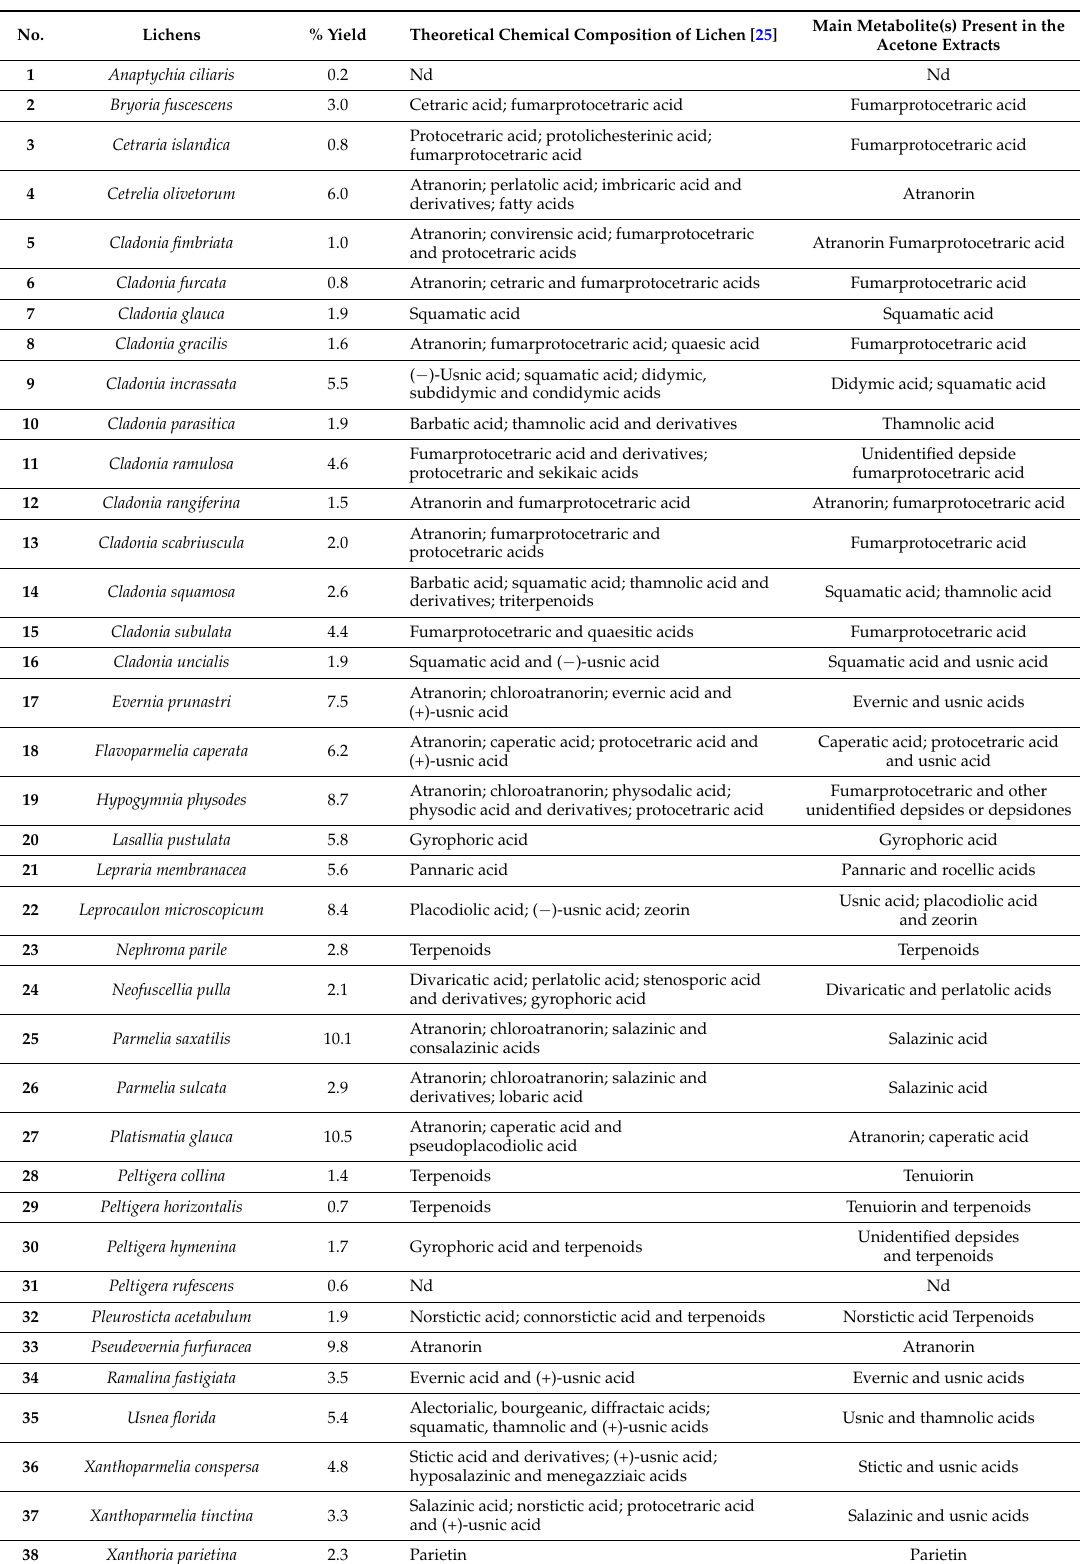
Table 1. Lichen species, extraction rates, and chemical composition of the lichens reported in the literature data and the main metabolites present in acetone extracts (determined by TLC and/or HPLC). Nd = non